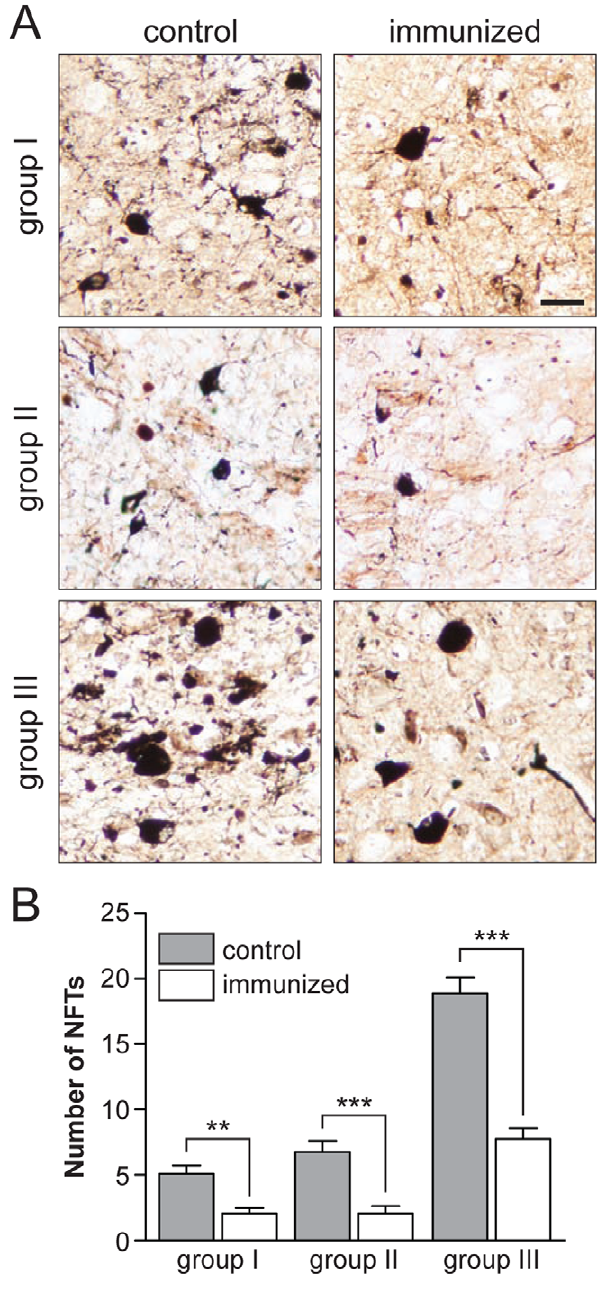
Figure 3. Tau-immunized pR5 mice have less NFTs. ( A ) Gallyas silver staining of coronal brain sections from 14 (group I), 17 (group II) and 24 (group III) months-old pR5 mice, respectively. Representative images of amygdalae of control pR5 brains of all three groups reveal numerous Gallyas silver-positive NFTs (‘flame shaped’), together with dystrophic neurites. In the brains of immunized pR5 mice, there are much less NFTs and dystrophic neurites stained, suggesting reduced NFT pathology. Scale bar, 25 m m. ( B ) Quantification of NFT numbers in serial sections from control and immunized pR5 mice stained with Gallays silver impregnation shows significantly reduced NFT numbers in immunized pR5 mice in all three treatment groups, compared to the respective controls. **, p , 0.001 and ***, p , 0.0001; Student t -test (controls vs. immunized); n=12 for group I and II, and n=8 for group III.